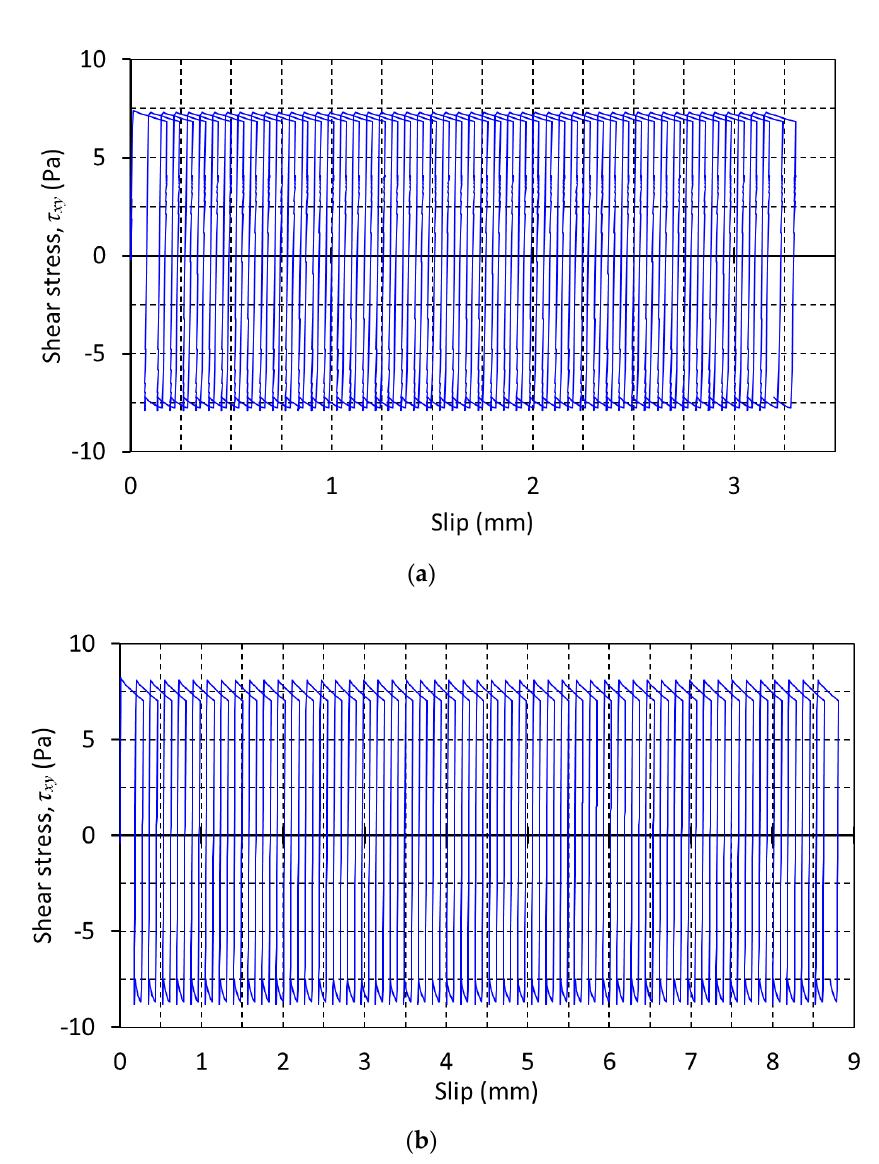
Figure 15. The slip build-up during the 50 temperature cycles. The presented results are based on the parameters in Table 1 with ( a ) ∆𝑇 = 23 ℃ in 𝛽 = 5° slope and ( b ) ∆𝑇 = 31 ℃ in 𝛽 = 10° slope.